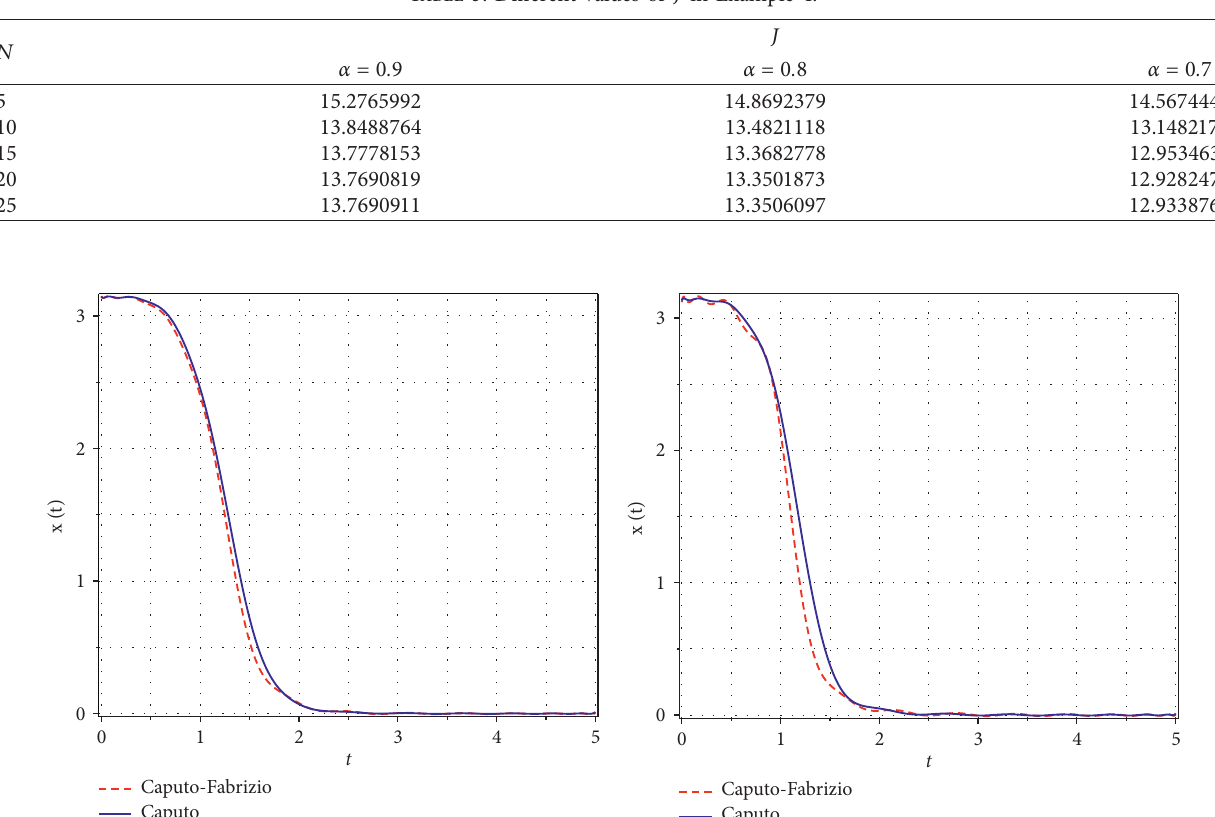
Figure 5: Approximate solutions of x ( . ) and u ( . ) with N � 25 in Example 4. (a) Approximate solution of u ( . ) for α � 0.7, 0.8, and 0.9. (b) Approximate solution of u ( . ) for α � 0.7, 0.8, and 0.9. Table 5: Different values of J in Example 4.